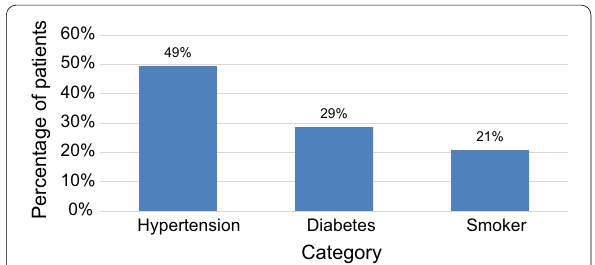
Fig. 1 Proportion of patients with hypertension, diabetes and smokers